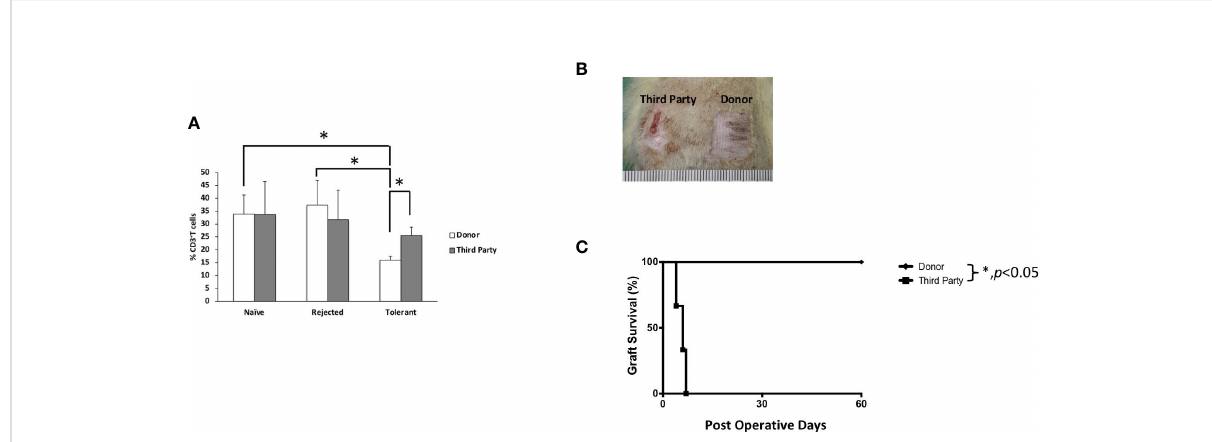
tolerance. (A) Mixed lymphocyte reaction study. (B) Secondary full-thickness skin allograft and Kaplan – Meier survival analysis of skin allograft survival. The asterisk denotes statistical signi fi cance ( p < 0.05).